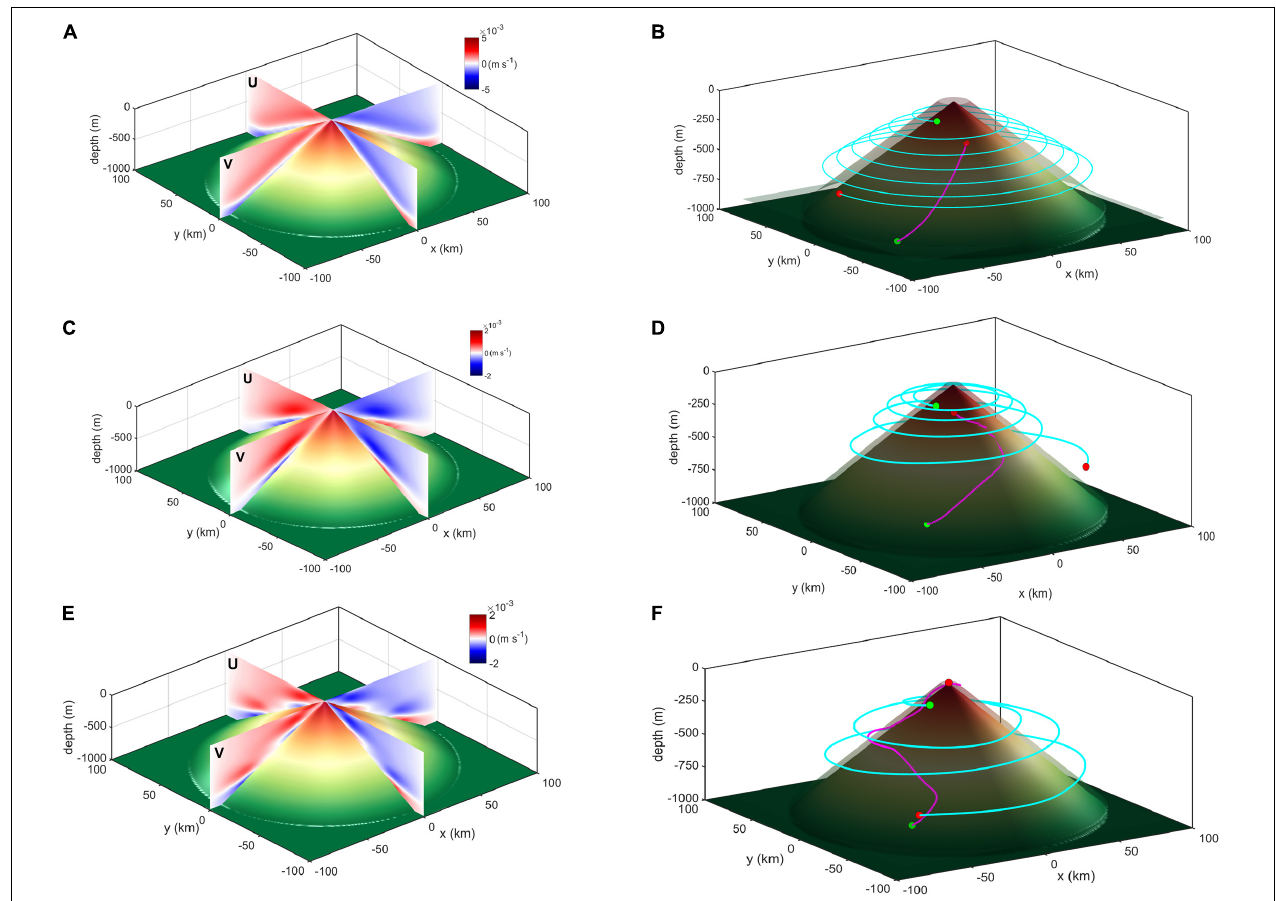
FIGURE 11 | (A,C,E) Three-dimensional horizontal flow driven by the bottom-intensified turbulent mixing around the seamount of Exp1, Exp2, and Exp3, respectively (displayed in Figures 8A,D,G ). (B,D,F) Upward spiraling pathway of fluid particles (magenta solid line) in the BBL and downward spiraling pathway of fluid particles (cyan solid line) outside the BBL of Exp1, Exp2, and Exp3, respectively, with the green dot indicating the start point and the red dot indicating the